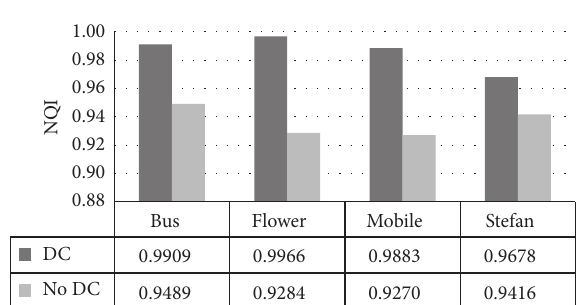
Figure 12: NQI comparison between schemes with DC and without DC (DC stands for drift compensation).